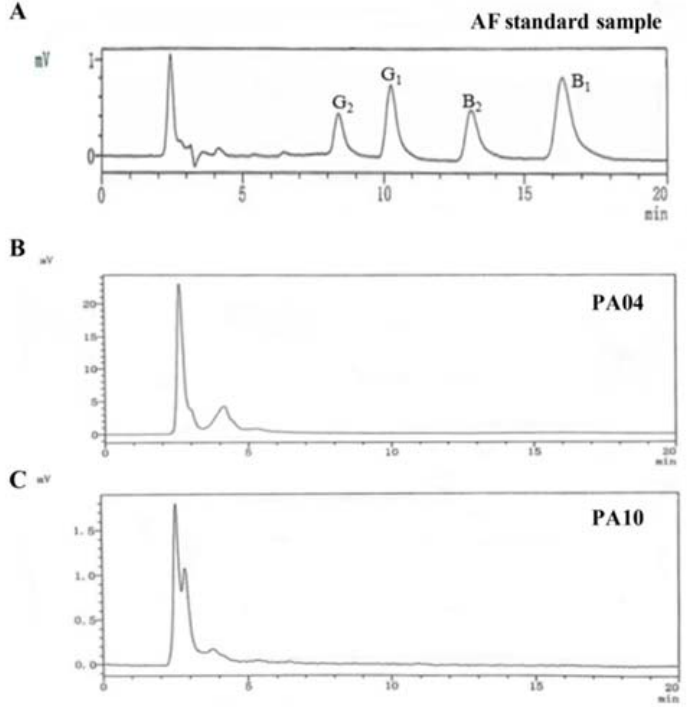
Figure 2. High performance liquid chromatography (HPLC) chromatogram indicating aflatoxin standard sample ( A ) and lack of aflatoxin production on YES medium (30 °C, 7 d) by both A. flavus PA04 ( B ) and PA10 ( C ).